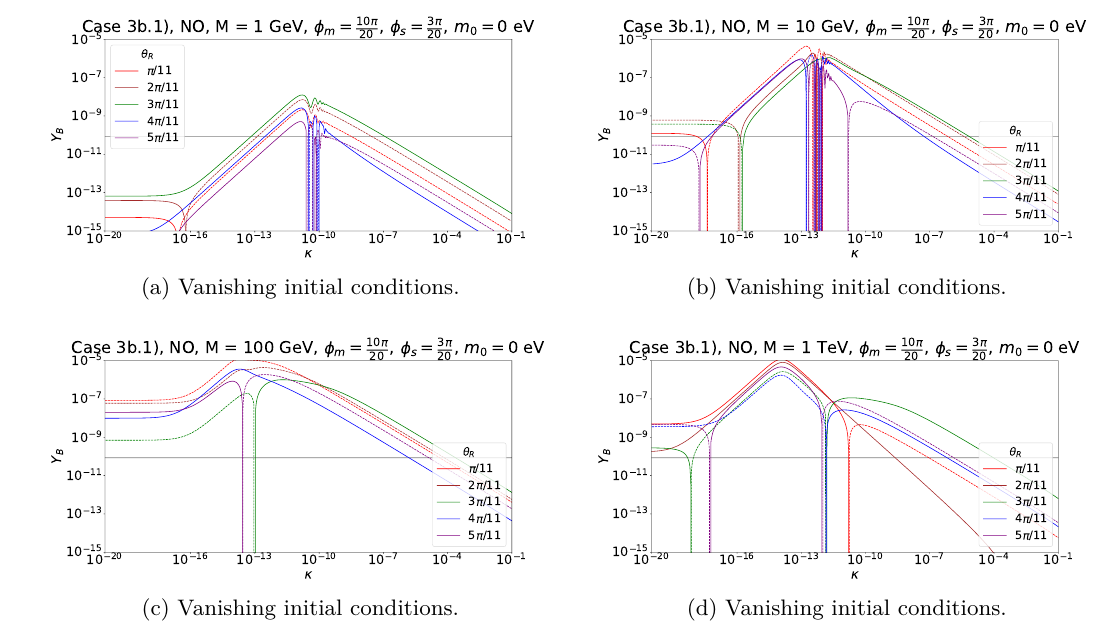
Figure 22 . Case 3 b.1) Y B as function of the splitting κ for a Majorana mass M = 1 GeV (upper left plot), M = 10 GeV (upper right plot), M = 100 GeV (lower left plot) and M = 1 TeV (lower right plot). For each of these plots, different values of θ have been studied. The group theory R parameters n , m and s are fixed to n = 20 , m = 10 and s = 3 . Light neutrino masses follow strong NO. For the rest of the choices see figure